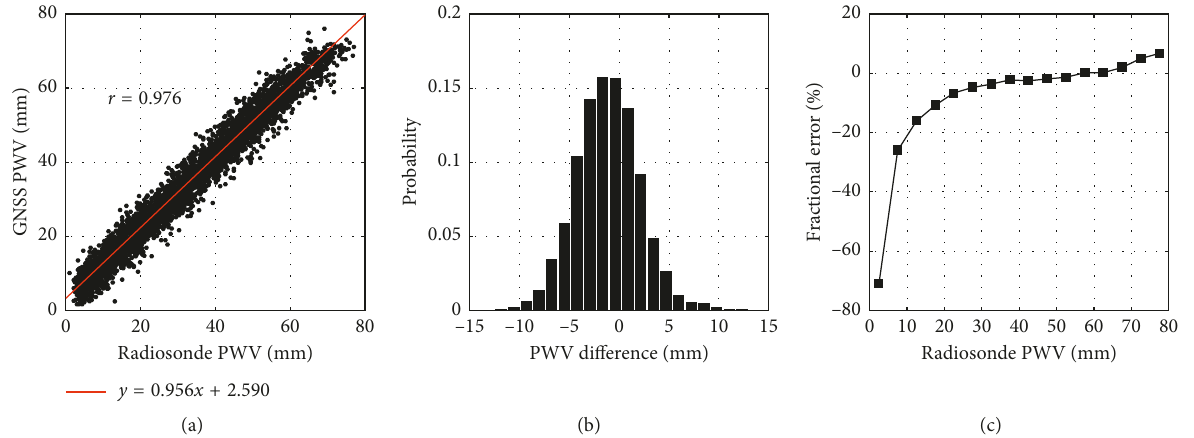
Figure 2: (a) Scatter plot of radiosonde PWV versus GNSS PWV, (b) PDF of PWV difference between radiosonde and GNSS, and (c) fractional error as percent by radiosonde 5mm PWV